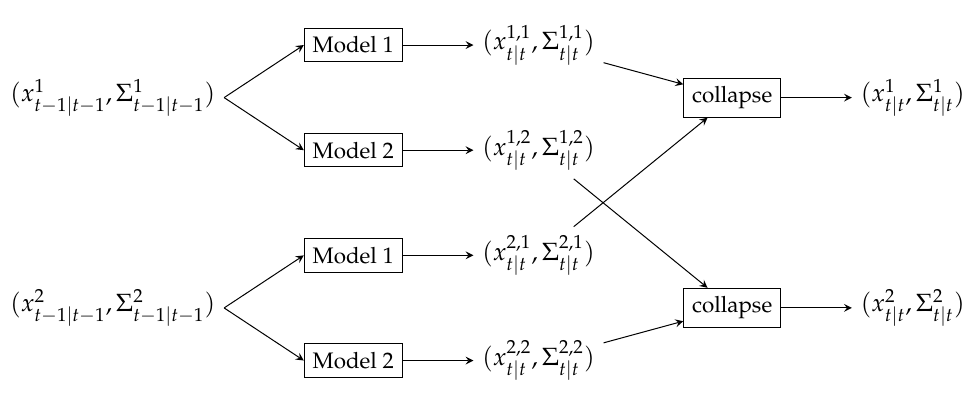
Figure 2. Mixture of Kalman filters; discrete variables are drawn in squares, Gaussian variables are drawn in ellipses. ( a ) Switching estimations; ( b ) Switching observations; ( c ) Switching estimations with factored state.